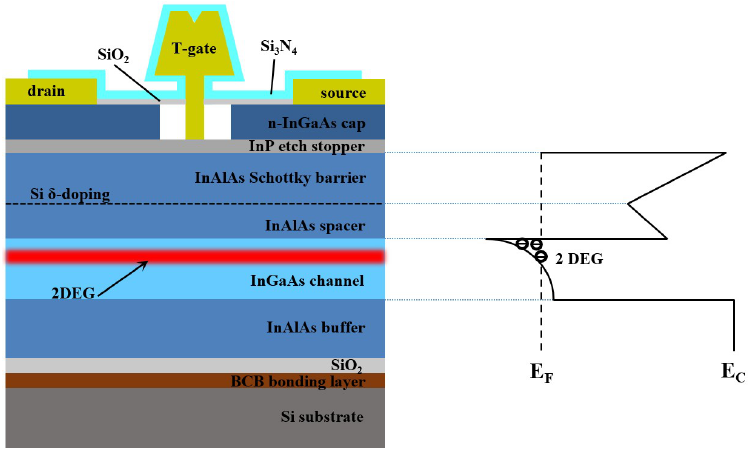
Figure 3. The schematic cross section of the passivated InGaAs HEMTs on Si substrates and the band diagram of the